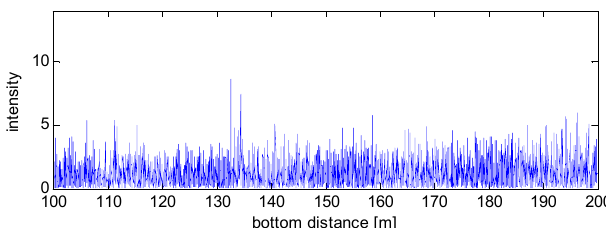
Figure 7. Matched filtering outputs obtained by the conventional approach without applying the time reversal technique.